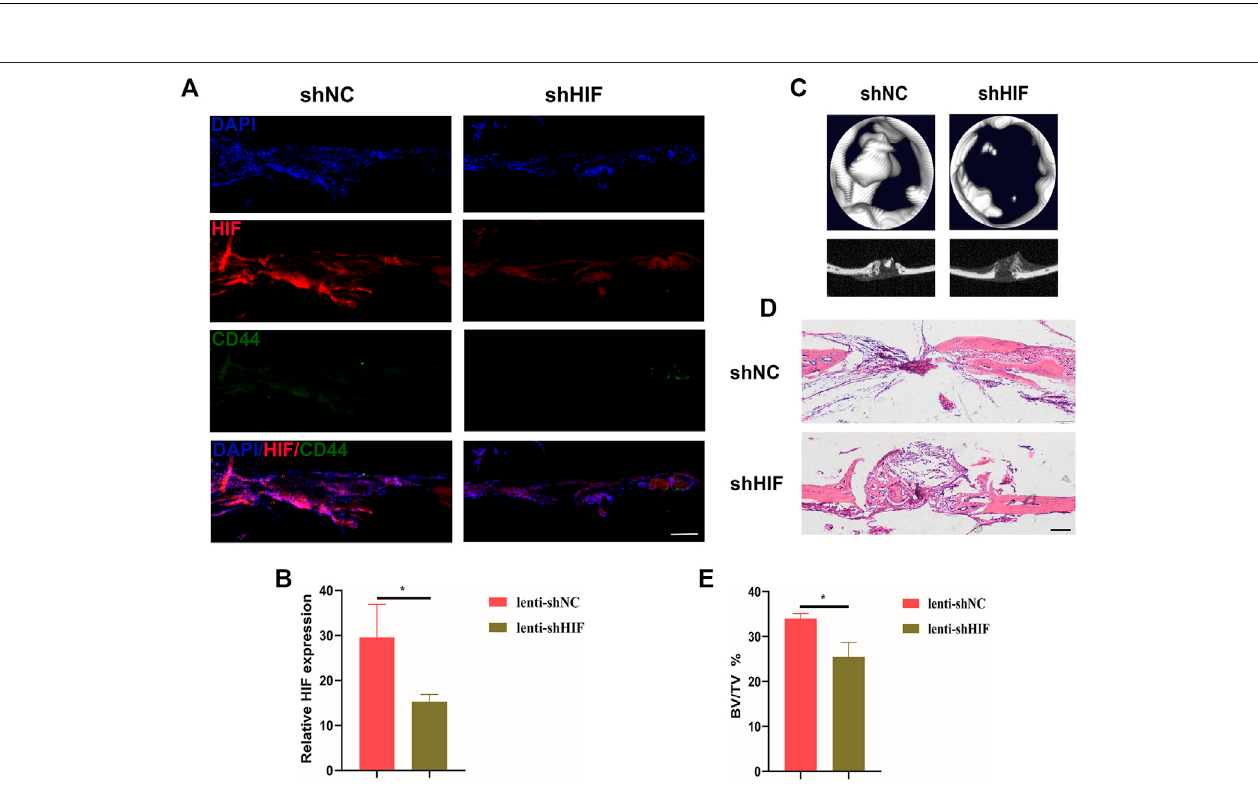
FIGURE 2 | Impaired HIF-1 α expression affects in vivo bone regeneration of mice. (A) The expression of HIF-1 α and CD44 + cells in the defected region of calvarial bone 20 days after surgery (scar bar: 100 μ m). (B) Semi-quanti fi cation results of HIF-1 α expression. (C) The 2D and 3D images for micro-CT results. (D) HE staining of defected calvarial bone, with shNC or shHIF injection, 20 days after surgery (scar bar: 100 μ m). (E) The analysis for bone volume/tissue volume (BV/TV) of micro-CT results. * indicates the signi fi cance tests between groups: * p < 0.05.